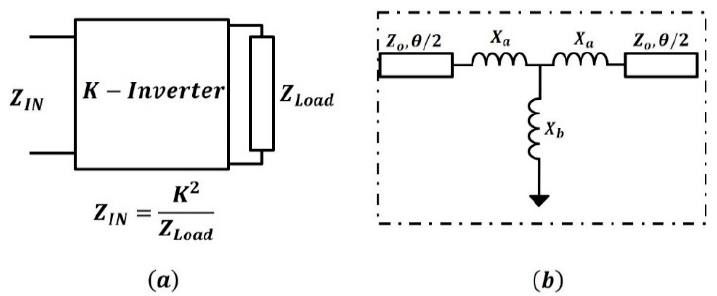
Figure 4. ( a ) Impedance relationship for the K-Inverter. ( b ) Equivalent circuit for the broadband